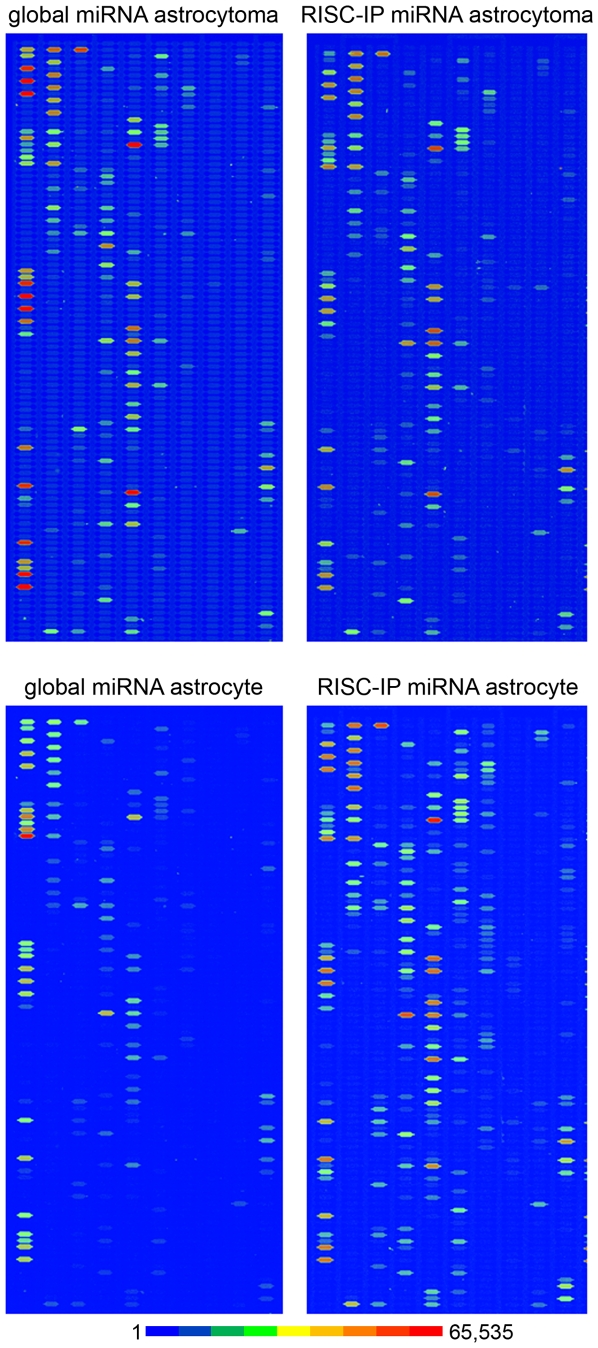
MiRNA microarray images of global and RISC-immunoprecipitated (RISC-IP) miRNA from human U-87 astrocytoma and primary human astrocyte cells.The representative chip images are displayed in pseudo colors to expand the visual dynamic range. As signal intensity increases from 1 to 65,535, the corresponding color changes from blue to green, to yellow and to red.